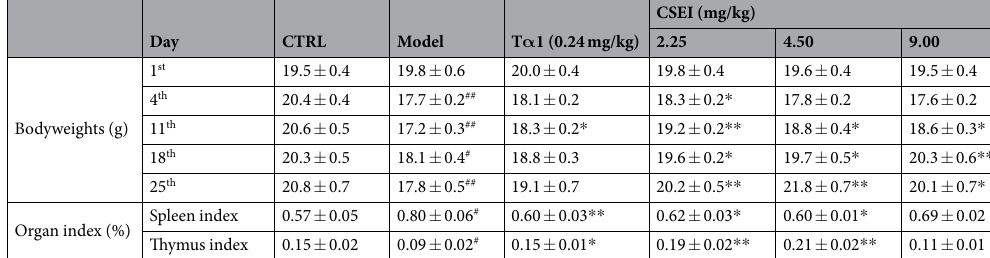
Table 1. CSEI regulated bodyweights and organ indices in CTX-injected mice with hematopoietic injury. 100 mg/kg of CTX was intraperitoneally injected to mice except controls for three days. Then T α 1 and CSEI were treated for another 21 days. The bodyweights of mice were monitored throughout the whole process. At the end of the experiment, spleen and thymus indices of mice were recorded. Data are showed as the means ± S.E.M. (n = 10). # P < 0.05 and ## P < 0.01 versus CTRL group, * P < 0.05 and ** P < 0.01 versus model